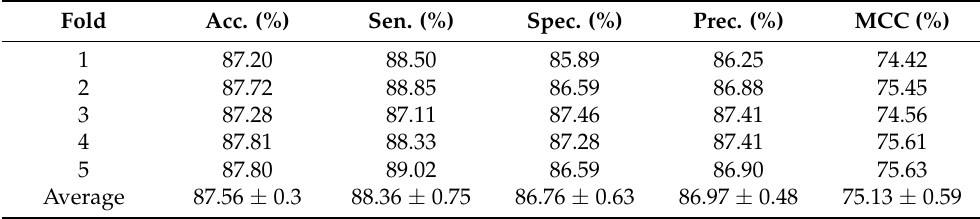
Table 3. The performance of the proposed method in RNAInter datasets.